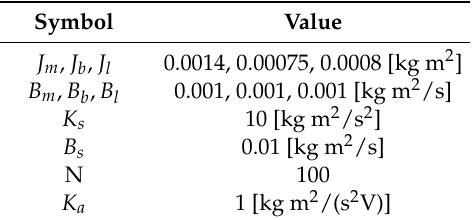
Table 3. System parameters.